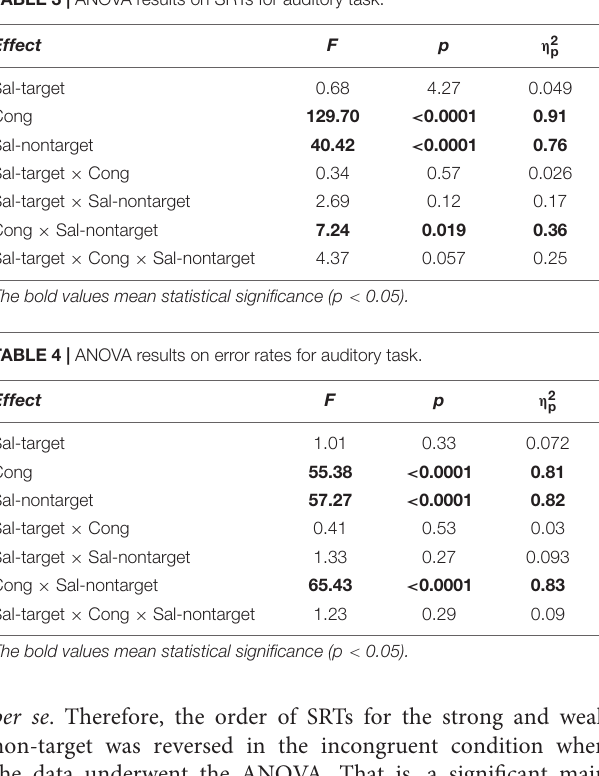
TABLE 3 | ANOVA results on SRTs for auditory task.